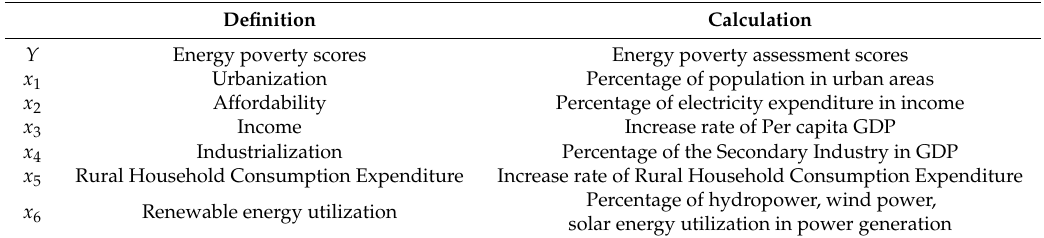
Table 3. Variables for panel data regression analysis of energy poverty.